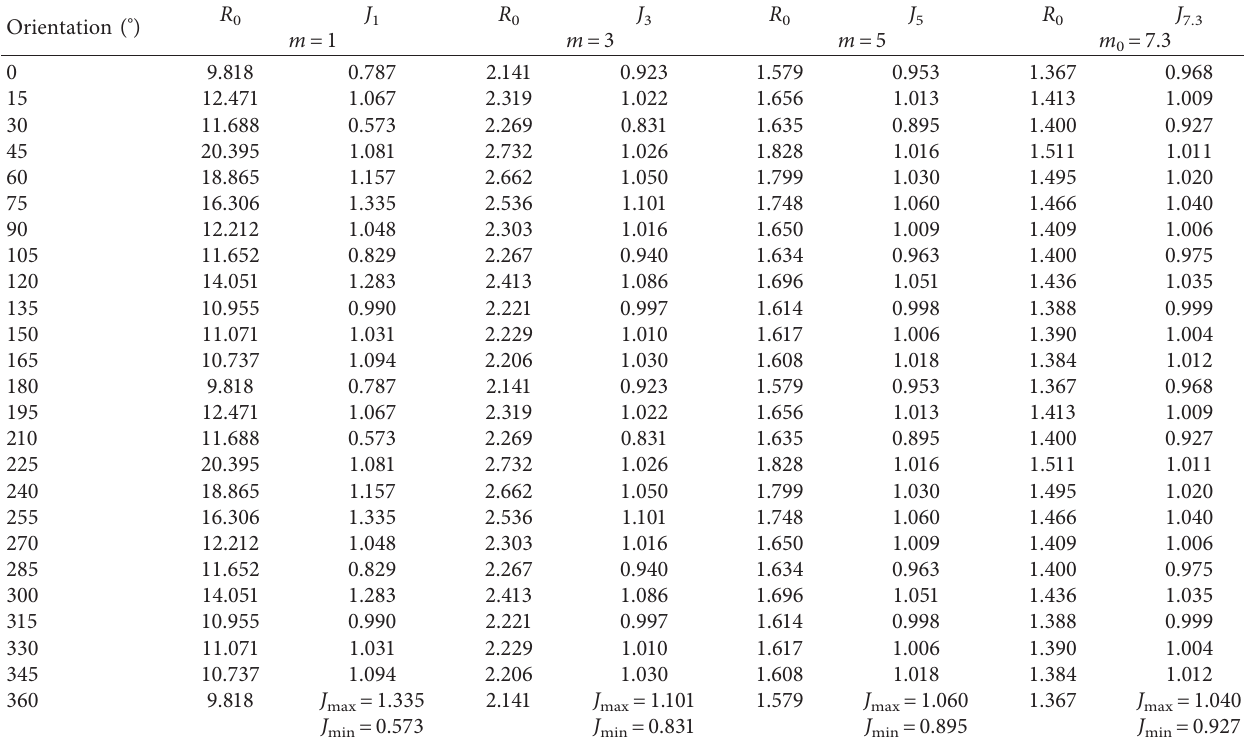
Table 1: Summary of the processed JRC data and class